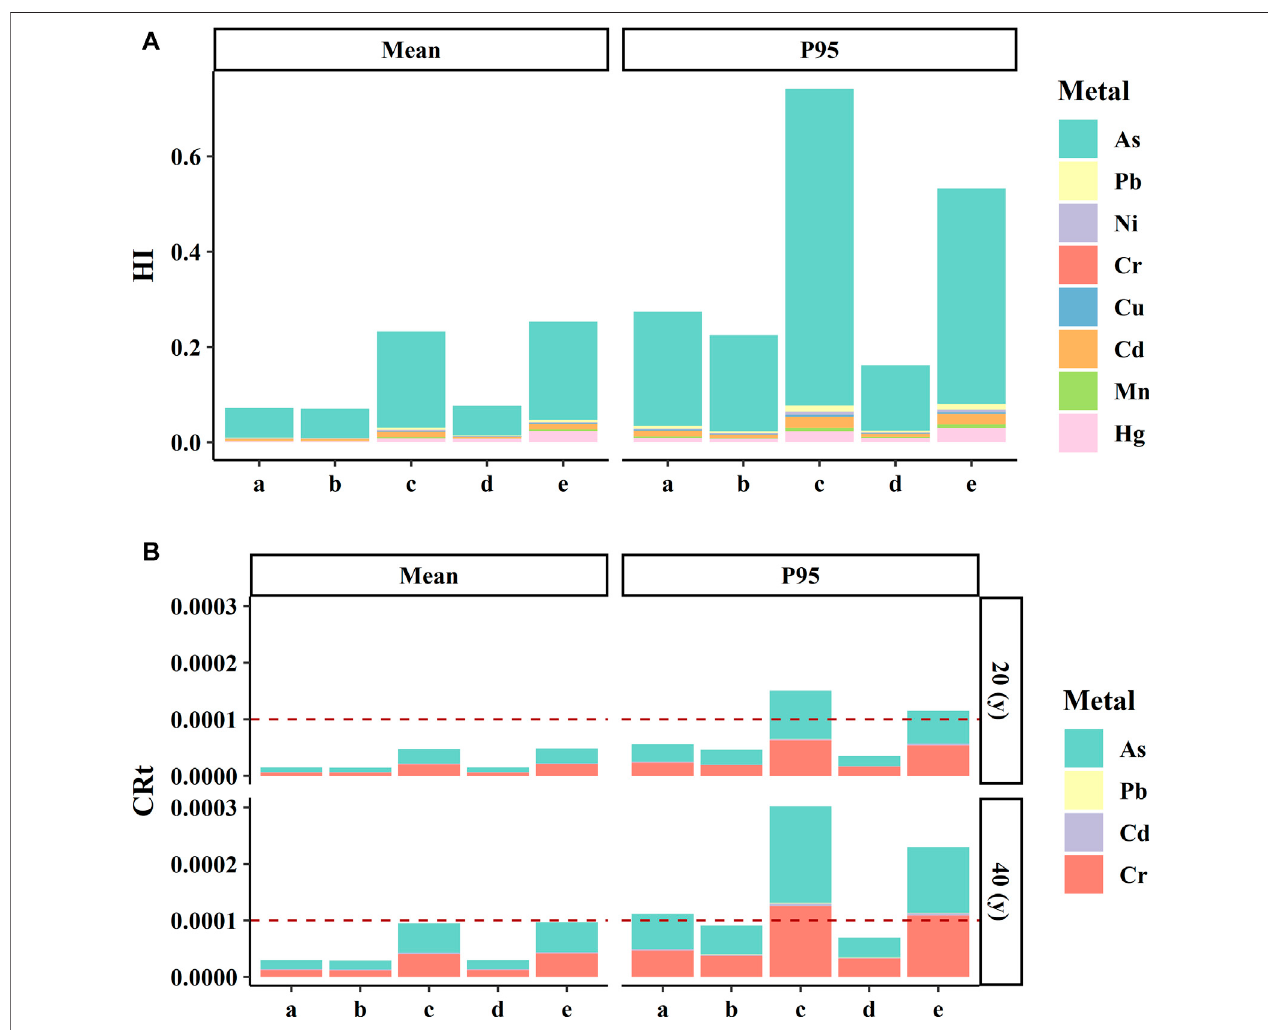
FIGURE 4 | The comparison of the comprehensive results of probabilistic and deterministic health risk assessment. (A) Comparison of the estimated non- carcinogenic risks (HQ) results of probabilistic and deterministic health risk assessment. (B) Comparison of the estimated carcinogenic risks (CR i ) results of probabilistic and deterministic health risk assessment. The letters a, b, c, d, e represent the probabilistic health risk assessment for random users, the probabilistic health risk assessment for average users, the probabilistic health risk assessment for high users, the deterministic health risk assessment for average users, the deterministic health risk assessment for high users, respectively. Red dashed lines: the acceptable limit of HQ and CR i , respectively.